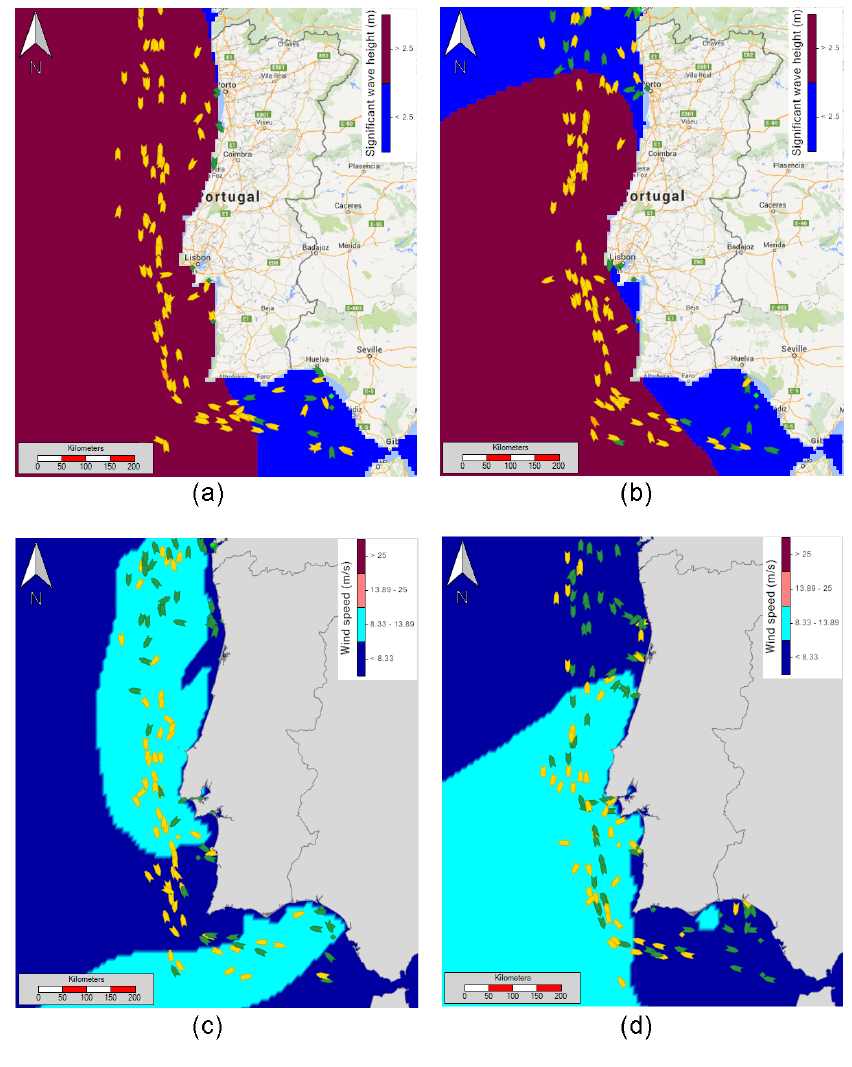
Figure 6. Ship incident risk levels (green ships mean lower risk, yellow means medium risk and orange ships mean higher risk) in the pilot area with background metocean conditions used. Computation is made with same vessel positions as used in Fig. 5. ( a and b ) Significant wave height on 18 June 12:00h and 19 June 2013 00:00h respectively; ( c and d ) wind speed on 19 June 06:00h and 22 June 2013 06:00h,